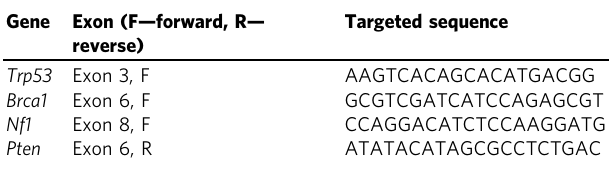
Table 3 Sequences targeted by designed